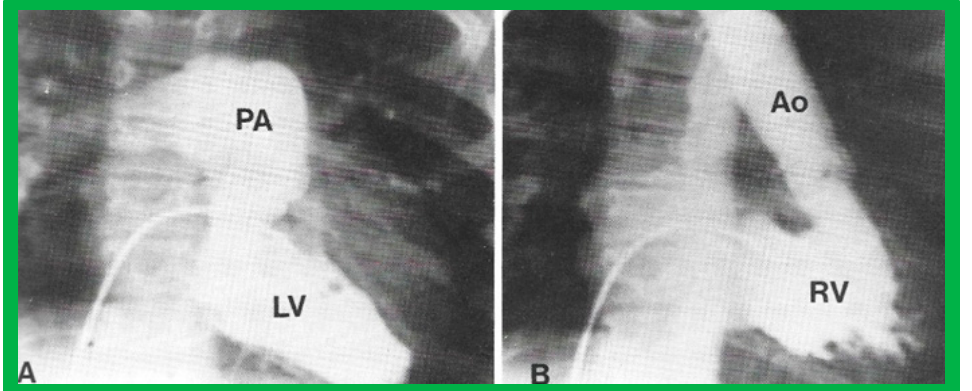
Figure 41. Cine images demonstrating an l-loop with the aortic valve located to the left of the pulmonary valve in a baby with corrected transposition of the great vessels. The aortic valve is also superior ( B ) and anterior (in lateral view—not shown) of the pulmonary valve. ( A ) Smooth-walled morphologic left ventricle (LV) is on the right side, giving origin to the pulmonary artery (PA). ( B ) Left-sided, morphologic right ventricle (RV) is coarsely trabeculated and gives origin to the aorta (Ao). The angiogram in ( B ) was obtained via a catheter positioned from the inferior vena cava to the right atrium, then into the left atrium through a patent foramen ovale, and then into the morphologic RV. Replicated from reference [39].